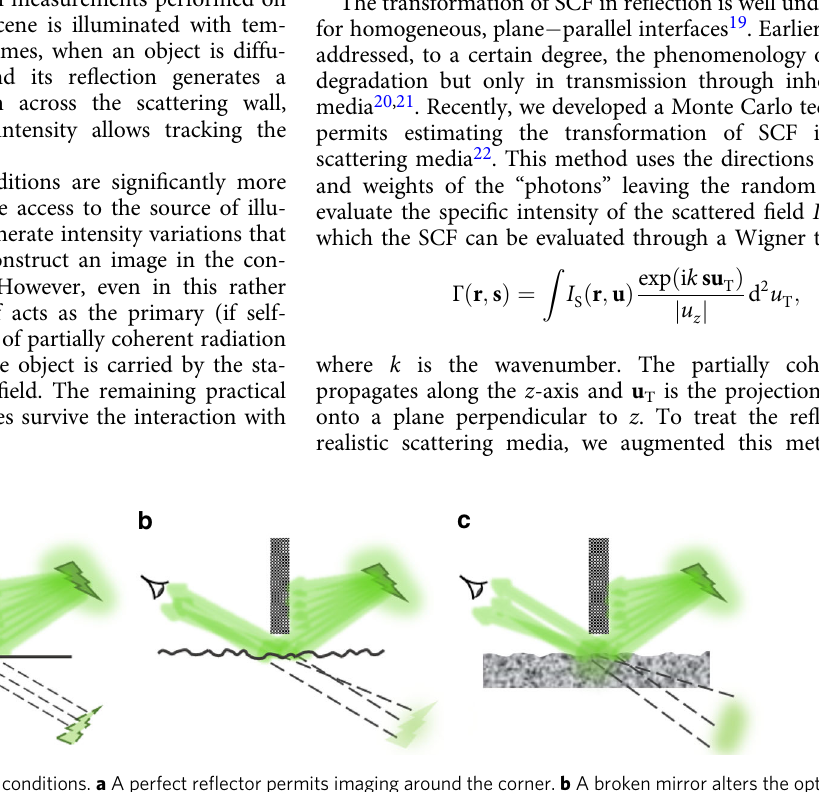
Fig. 1 Different non-line-of-sight sensing conditions. a A perfect re fl ector permits imaging around the corner. b A broken mirror alters the optical wavefront and impedes forming a clear image. c A random medium will alter the re fl ection even more due to both surface and volume scattering